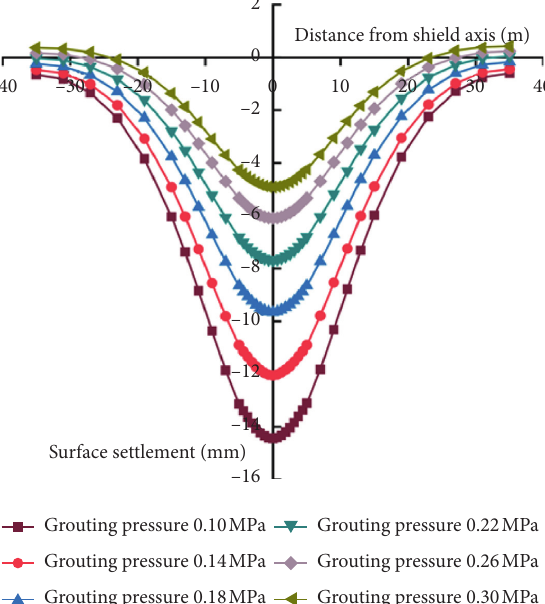
Figure 6: Surface settlement curve under different grouting